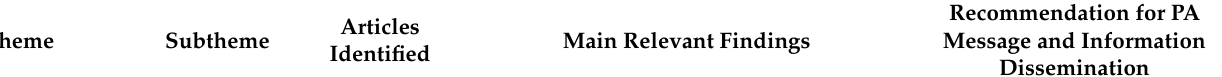
Table 3. Literature regarding the dissemination of physical activity messages targeting